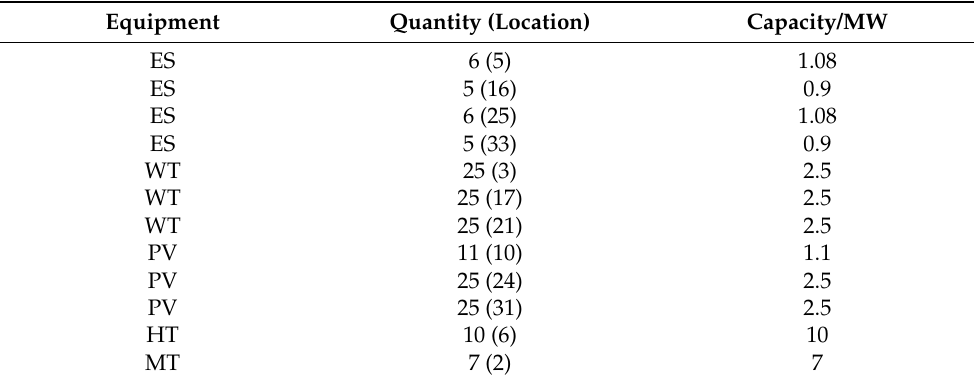
Table 1. IEEE33 NDN planning results considering GPCT and CET.